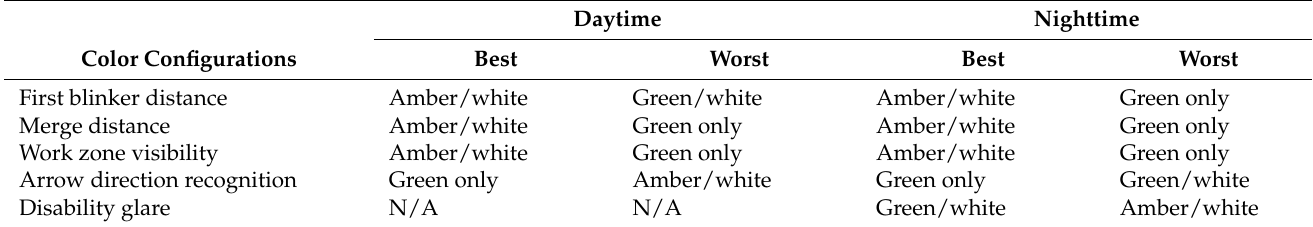
Table 5. Performance of various color configurations on TMA